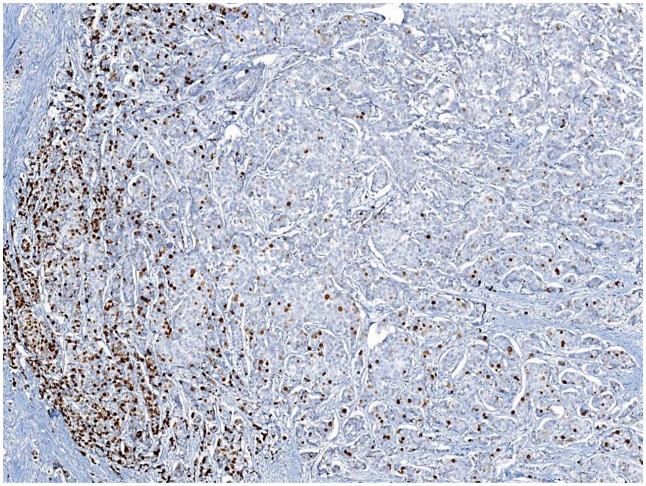
A heterogeneously stained case of Ki67.With a high Ki67 LI on the left and a low Ki67 LI on the right.